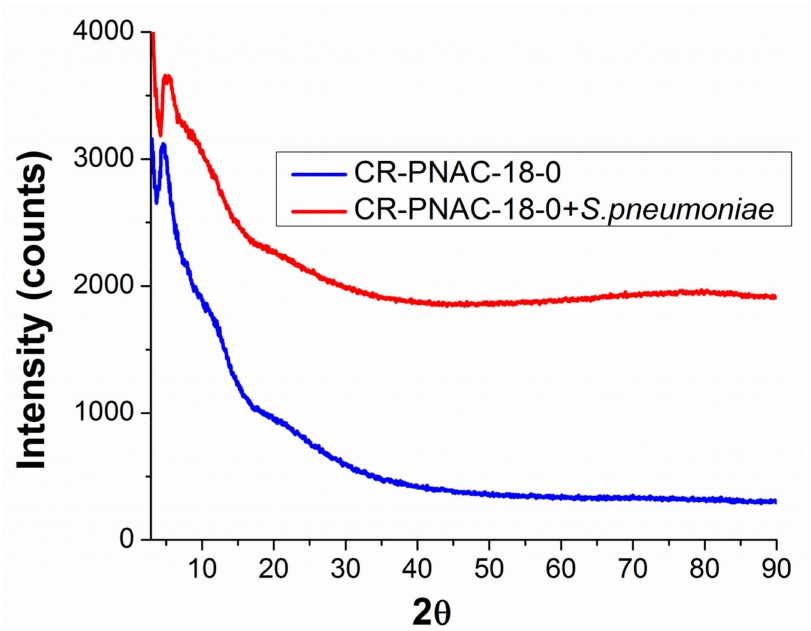
Figure 4. X-ray diffractogram (XRD) patterns of CR-PNAC-18-0 before ( red ) and after incubation with S. pneumoniae ( blue ).